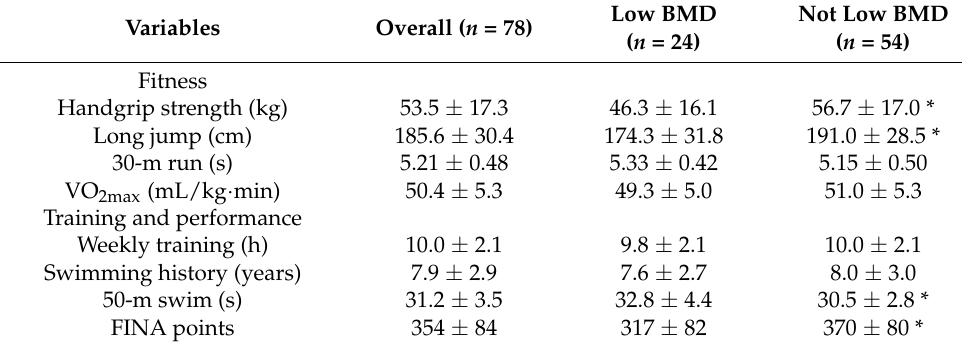
Table 2. Fitness and performance comparison between the subjects with and without low BMD.